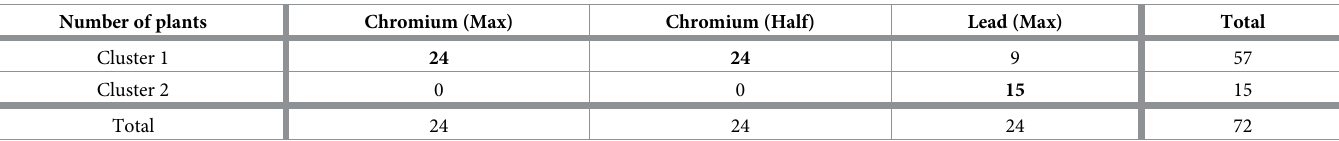
The chemical treatments (Chromium (Half and Max concentrations) and Lead (Max)) were clustered into two groups using the LSW–PCA clustering methodology. Note: The modal cluster for each treatment group is highlighted in